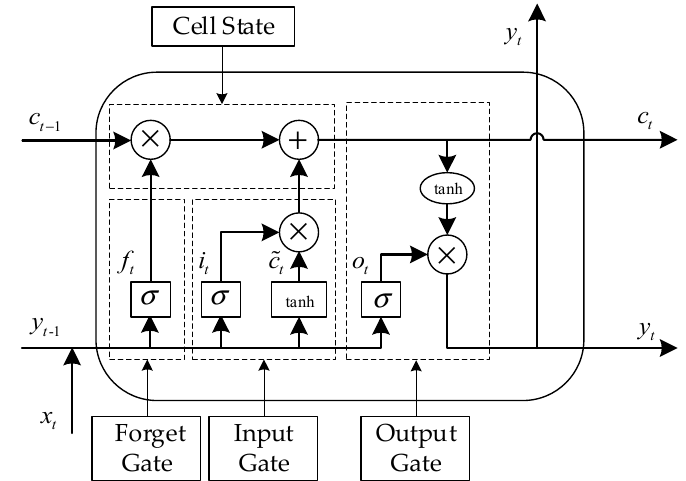
Figure 3. The LSTM network module.